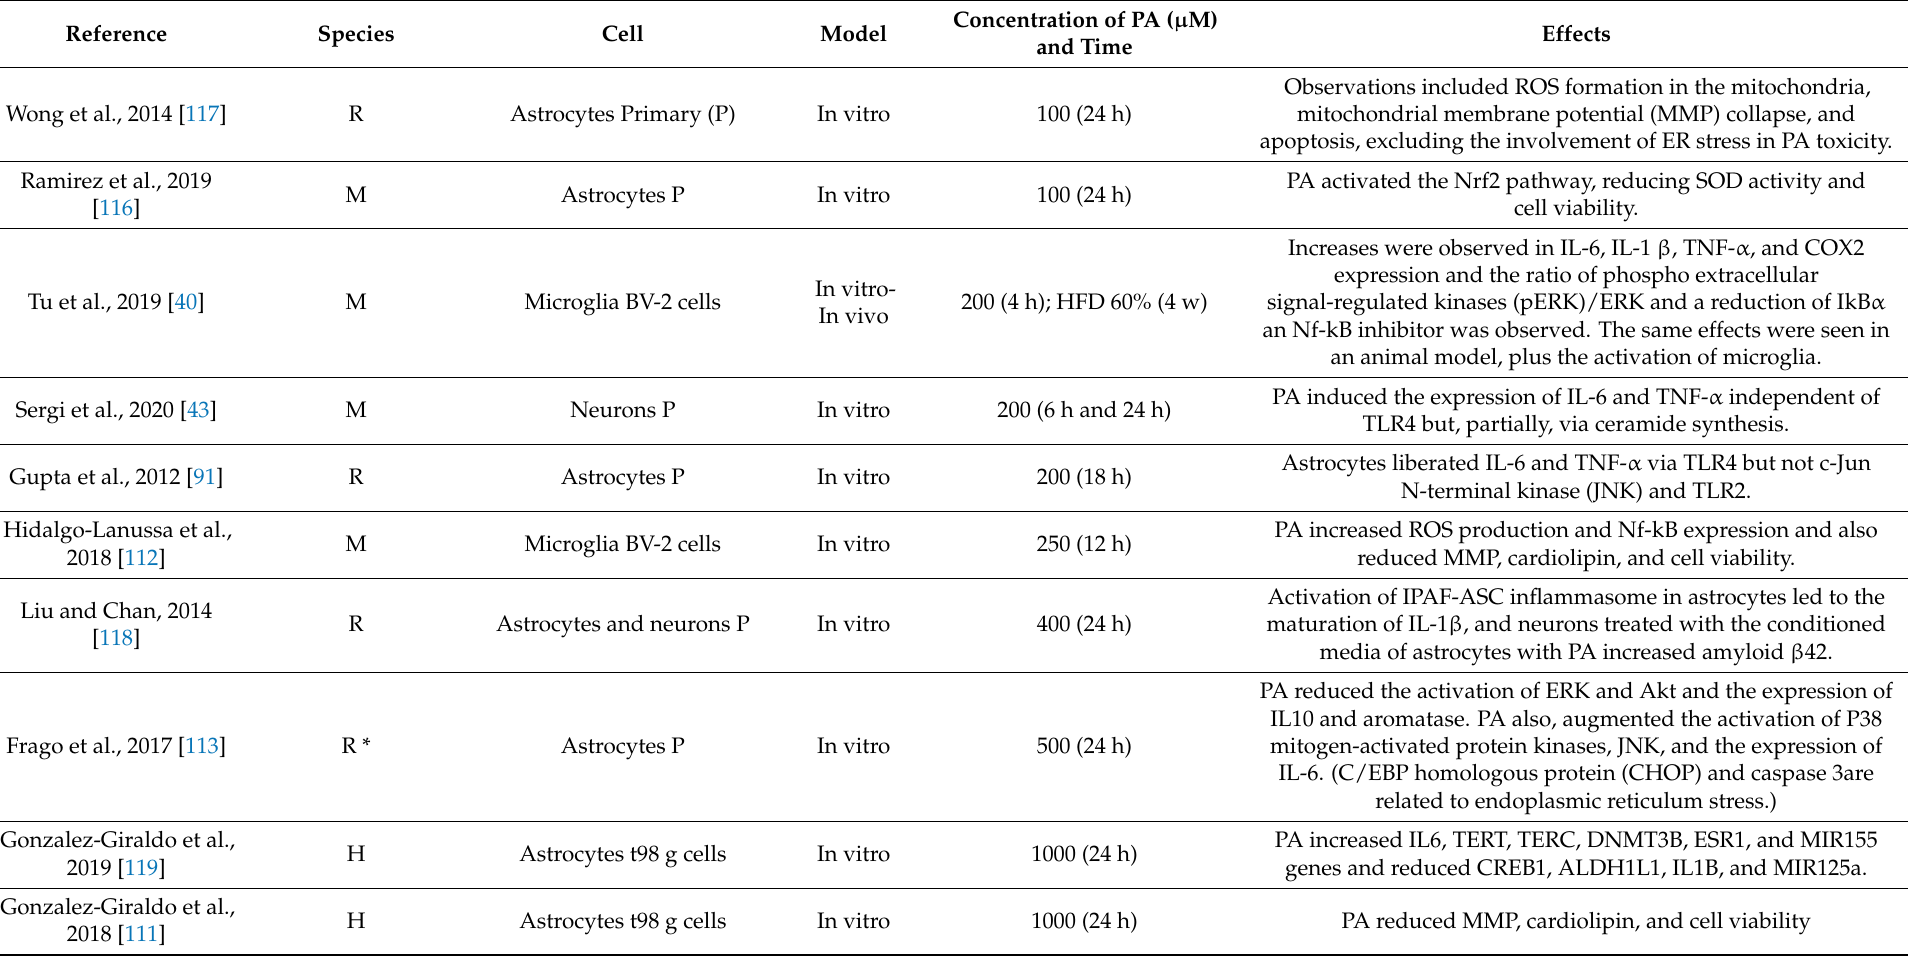
Table 2. List of the effects related to palmitic acid (PA) concentration and time of exposure to the insult in the different cells of the